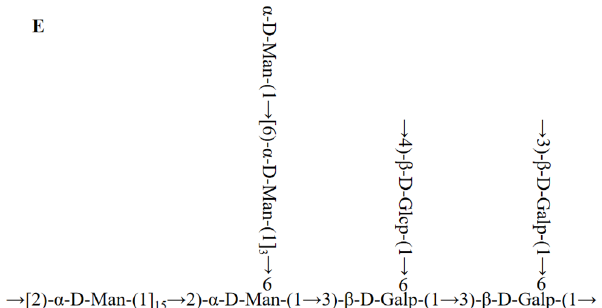
Figure 5. Two-dimensional NMR analysis of EPS2-1. ( A ) COSY spectrum; ( B ) HSQC spectrum; ( C ) HMBC spectrum; ( D ) NOESY spectrum; ( E ) The putative structure of EPS2-1. Table 3. 13 C-NMR and 1 H-NMR spectral assignments of EPS2-1. Glycosyl